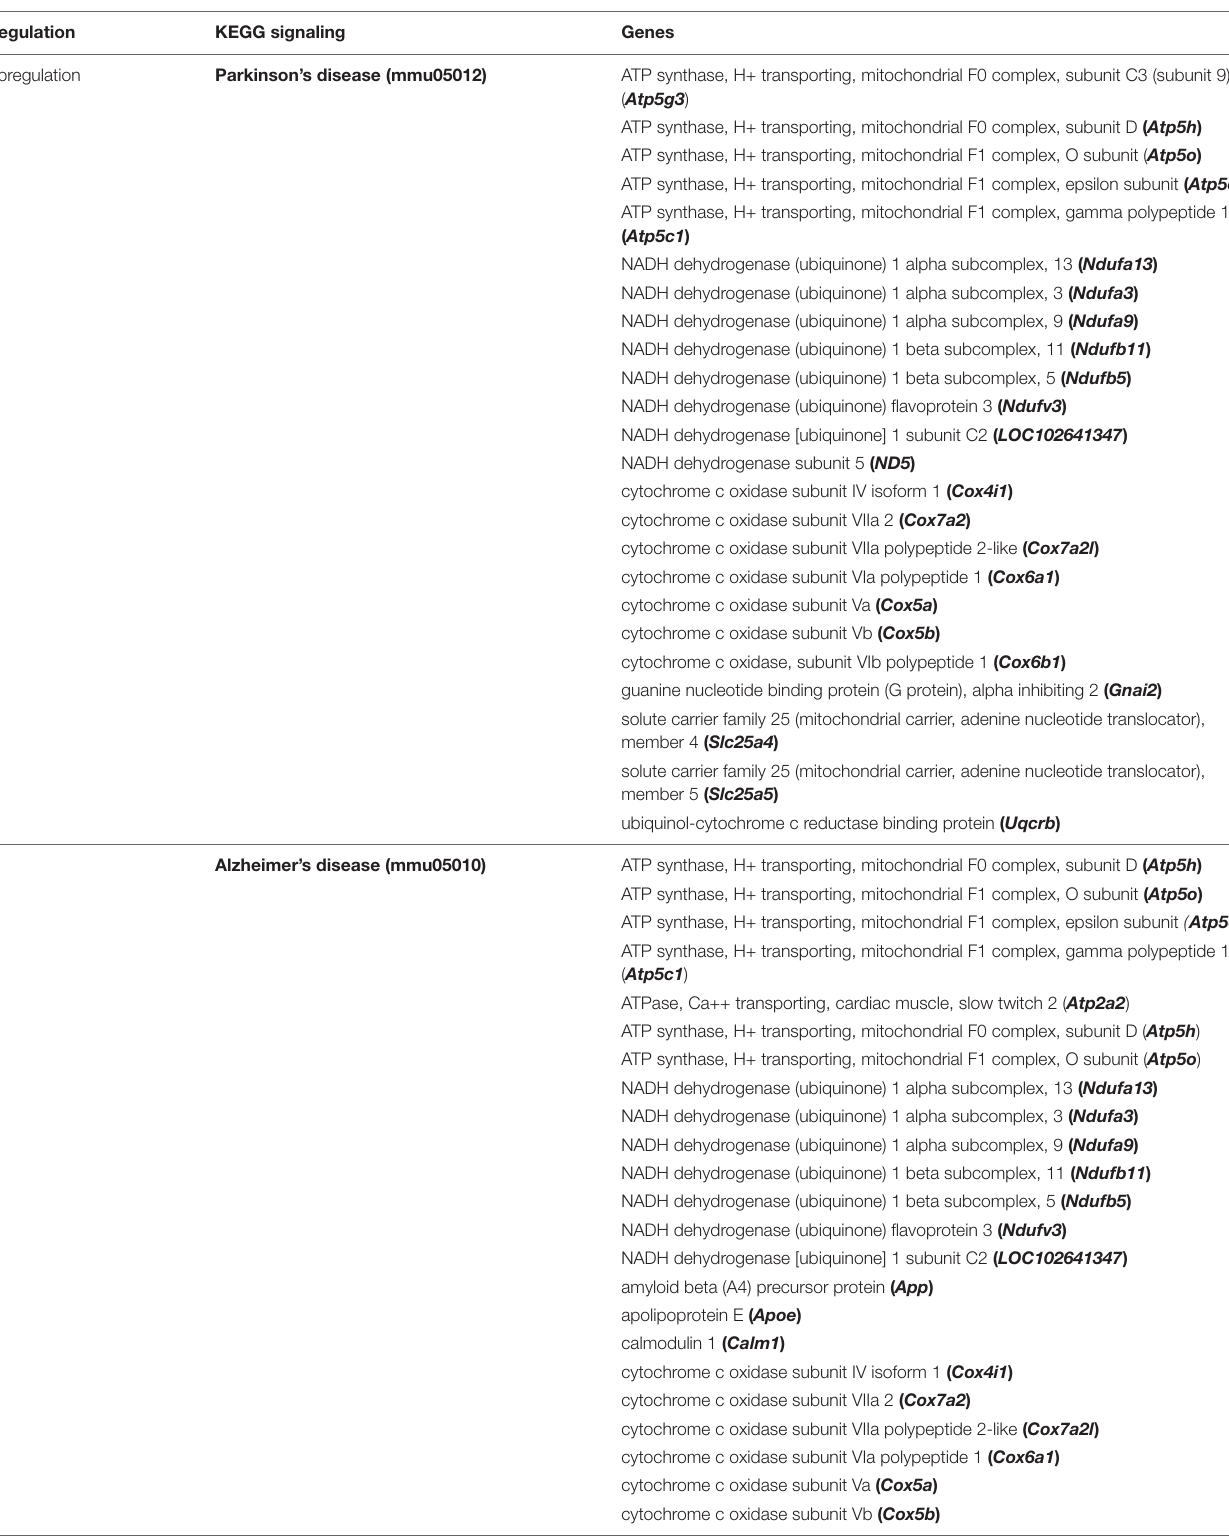
TABLE 2 | Top significantly enriched KEGG signaling pathways in NSCs of LPS-induced depression mice treated with luteolin (LPS + L) compared to untreated mice LPS-induced depression mice